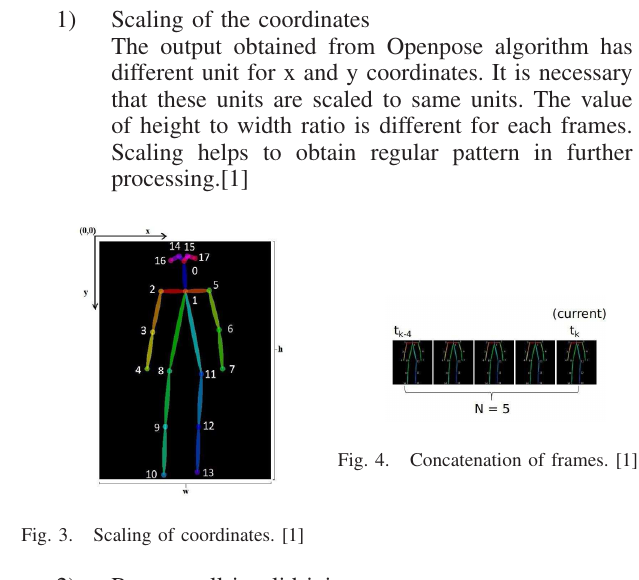
Fig. 3. Scaling of coordinates. [1]